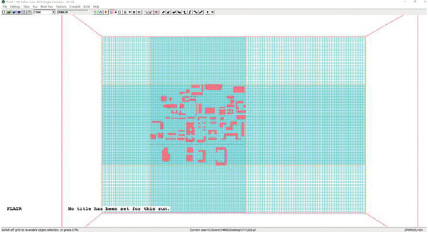
Figure 8: The grid of XY plane of the CUMTB campus.